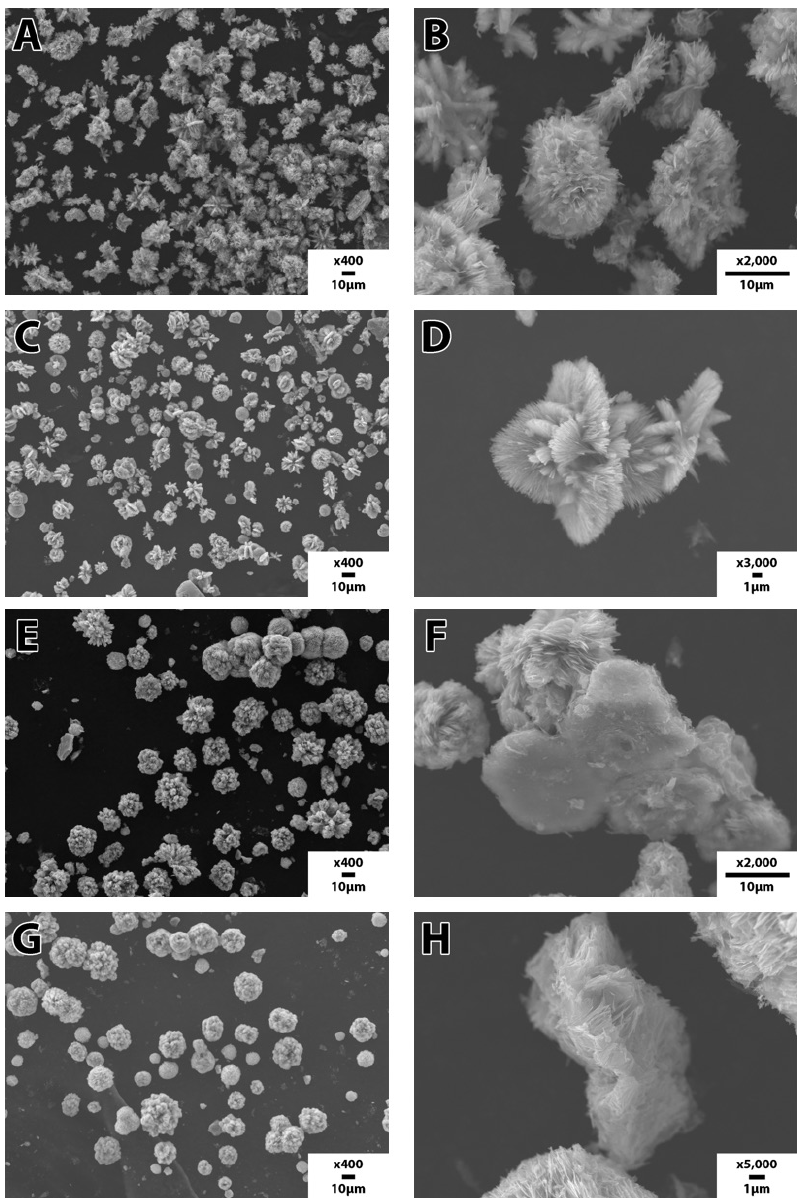
Figure 5. FEG-SEM images of: ZnO (A, B); ZnO/GO8 (C, D); ZnO/RGO100 (E, F); and ZnO/RGO600 (G, H).